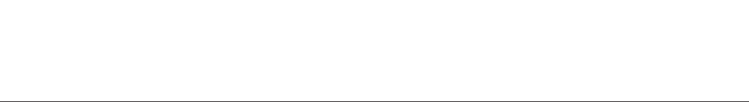
TABLE 3 | Assessment of CBD effects on mental health of